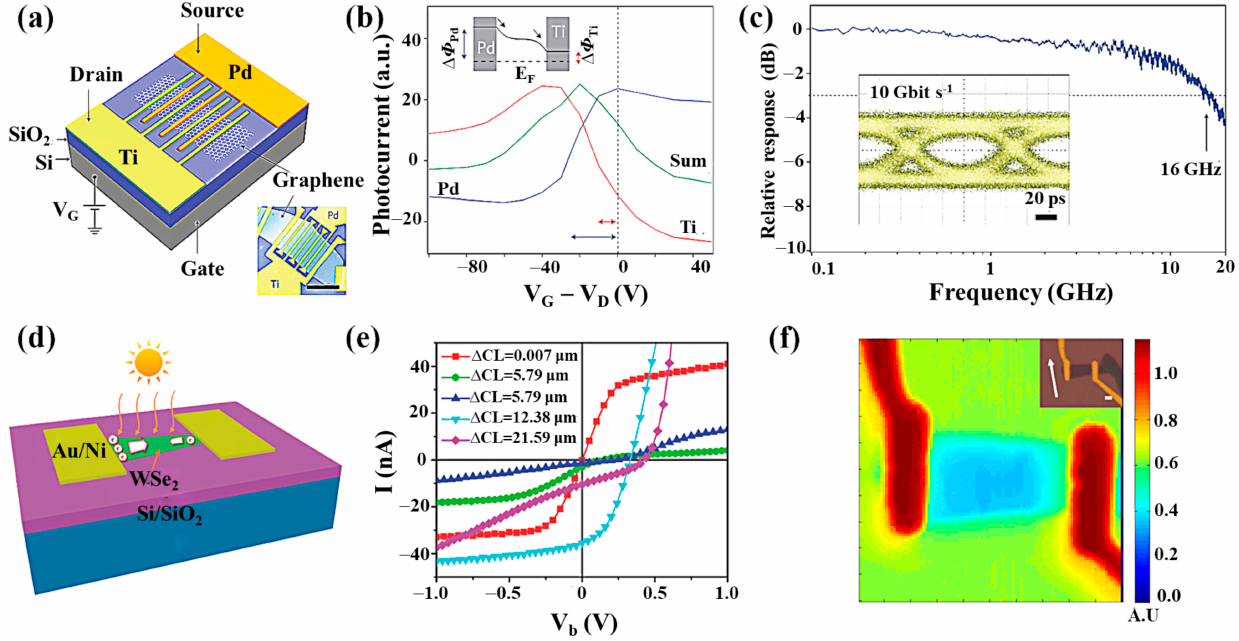
Figure 8. Metal/2D material structures. ( a ) Metal–graphene–metal (MGM) photodetectors with asymmetric metal contacts. ( b ) The dotted line denotes the Fermi level. ∆ φ Pd and ∆ φ Ti represent the difference between the Dirac point energy and the Fermi level in palladium- and titanium-doped graphenes, respectively. ( c ) Relative photoresponse versus light intensity modulation frequency. The -3dB bandwidth of this MGM photodetector is 16 GHz. Inset: receiver eye-diagram obtained using this MGM photodetector, showing a completely open eye. ( d ) Photodetectors with asymmetric contact geometries. ( e ) Photodetectors with different degrees of asymmetries. ( f ) Weyl semimetal scanning photocurrent response. ( a – c ) reproduced with permission from [5]. Copyright Nature Publishing Group, 2010. ( d , e ) reproduced with